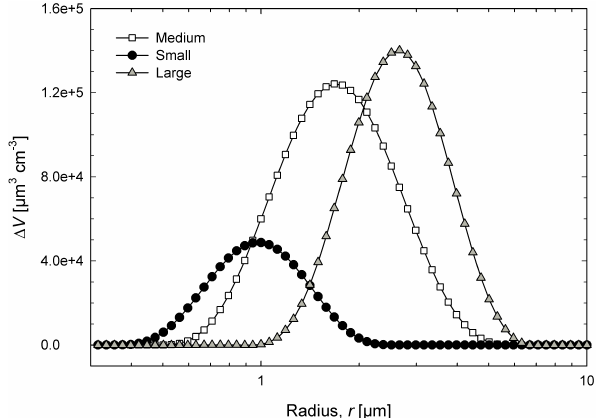
Fig. 2. Volume size distributions determined from the IR retrieval procedure (Sect. 2.2) for supercooled water droplets after condi- tioning at 240K. The droplets have mean radii of 1.0µm (small), 1.7µm (medium), and 2.9µm (large), corresponding to the genera- tion methods of heterogeneous condensation, atomization, and neb- ulization, respectively (Fig.